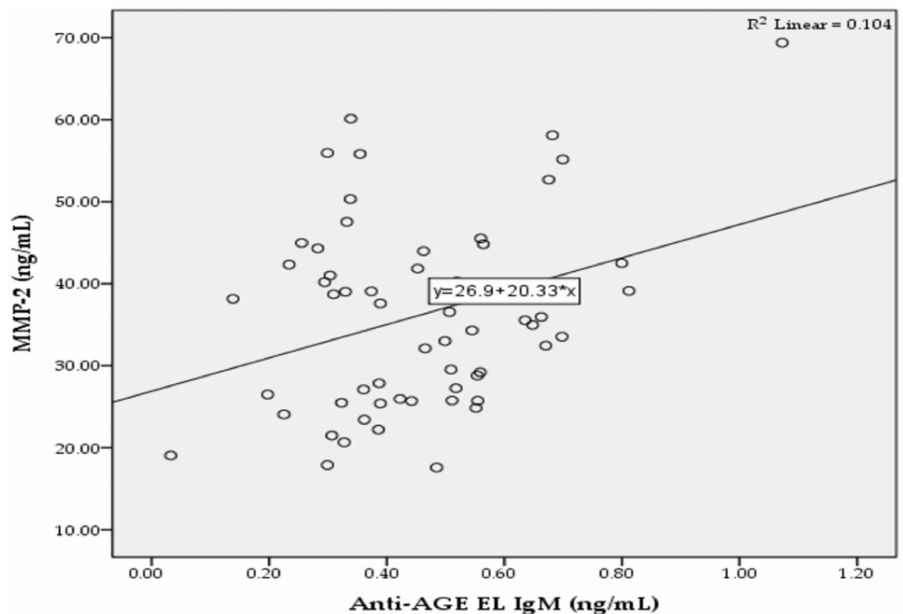
Figure 2. Correlation between the serum levels of anti-AGE EL IgM antibodies and MMP-2 in the T2D